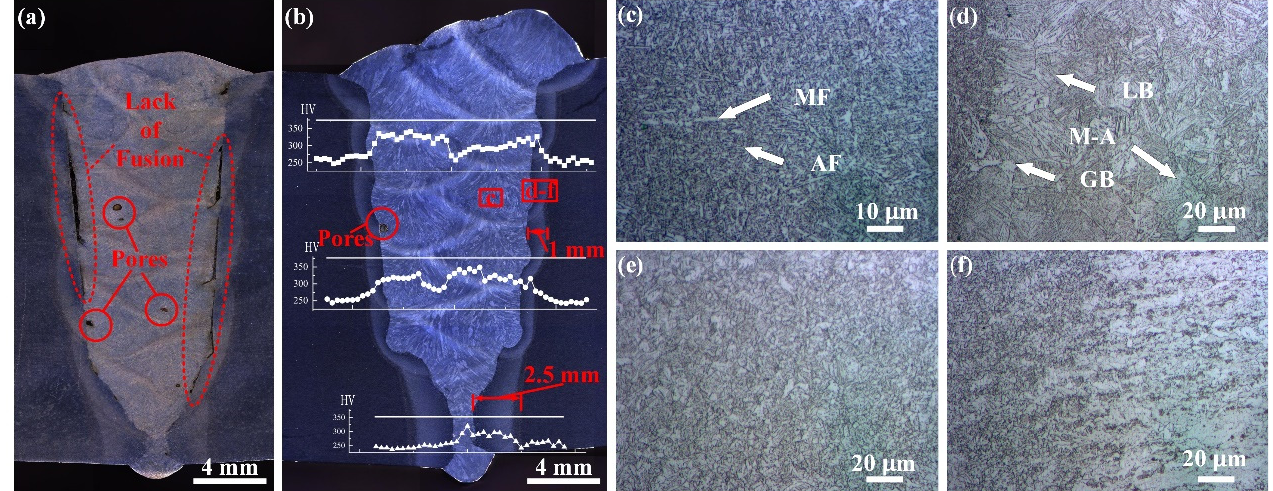
Figure 8. Joint macro/microstructure and microhardness: ( a ) joint with tradition distribution; ( b ) joint with misaligned distribution and microhardness; ( c – f ) microstructure of the joint.